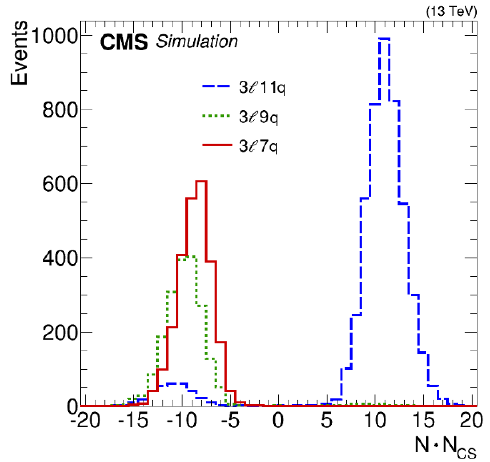
Figure 1 . Observed (cid:12)nal-state particle multiplicity N distributions for N CS = (cid:6) 1 sphaleron transitions resulting in 10, 12, and 14 parton-level (cid:12)nal-state multiplicities. The relative numbers of events in the histograms are proportional to the relative probabilities of these three parton- level con(cid:12)gurations. The peaks at positive values correspond to N CS = 1 transitions, while those at negative values correspond to N CS = (cid:0) 1 transitions and therefore are shifted toward lower multiplicity N because of cancellations with initial-state